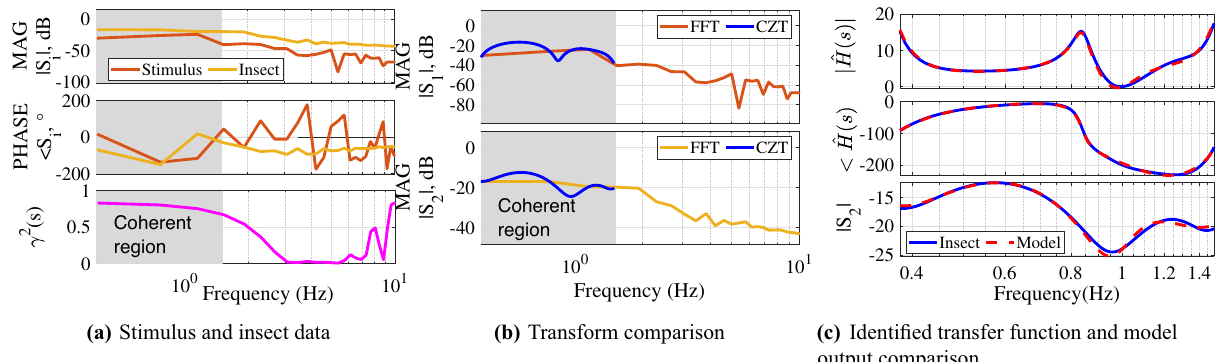
Figure 3. Frequency domain system identification example. ( a ) Magnitude, phase, and coherence γ 2 plots of the input stimulus S 1 and output (insect) position S 2 . A linear relationship between stimulus and insect position is indicated in the shaded region below 1.5 Hz where γ 2 > 0.6 , ( b ) Comparison of Fourier and Chirp Z-transform magnitudes for stimulus S 1 and insect S 2 in the region of highest coherence, ( c ) The identified transfer function G e ( s ) (dashed red) shows strong agreement with the measured frequency response ˆ H ( s ) (blue) in both magnitude and phase, as do true and identified model output | S 2 | .